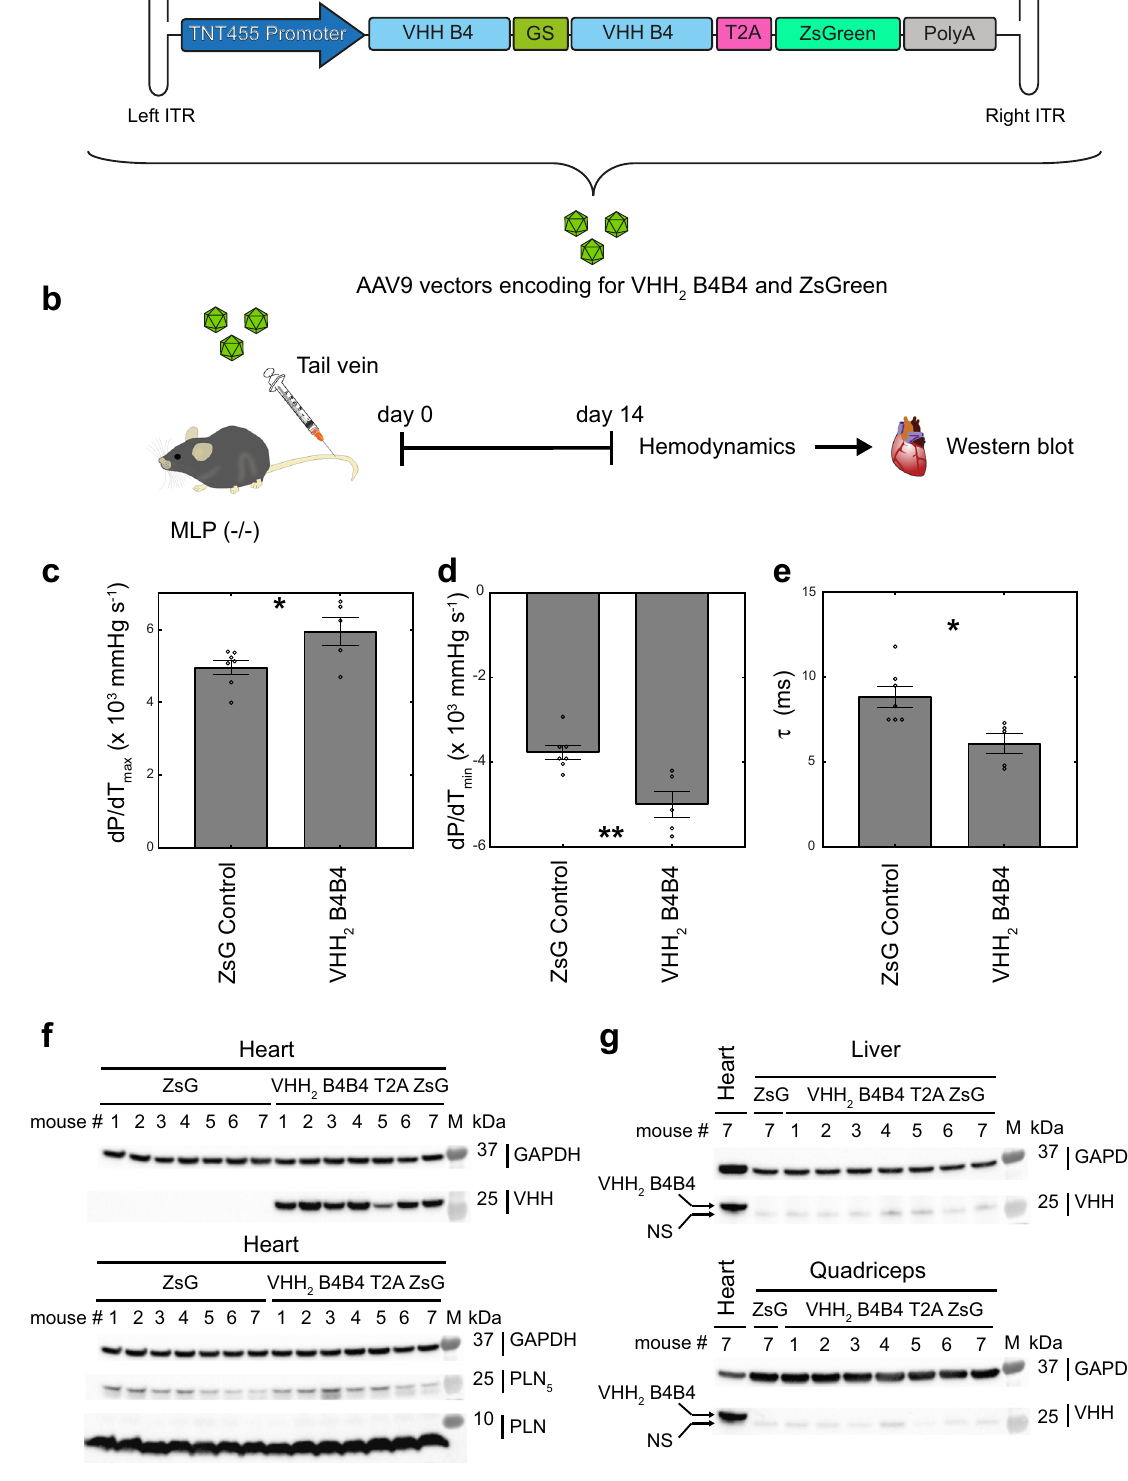
increase the apparent af fi nity of the monomeric intrabody by 300-fold for binding to non-phosphorylated PLN and by 600- fold for binding to pS16PLN. This relative ease by which manifold VHH constructs with enhanced properties can be generated has also been reported for VHHs with different speci fi cities 48,49